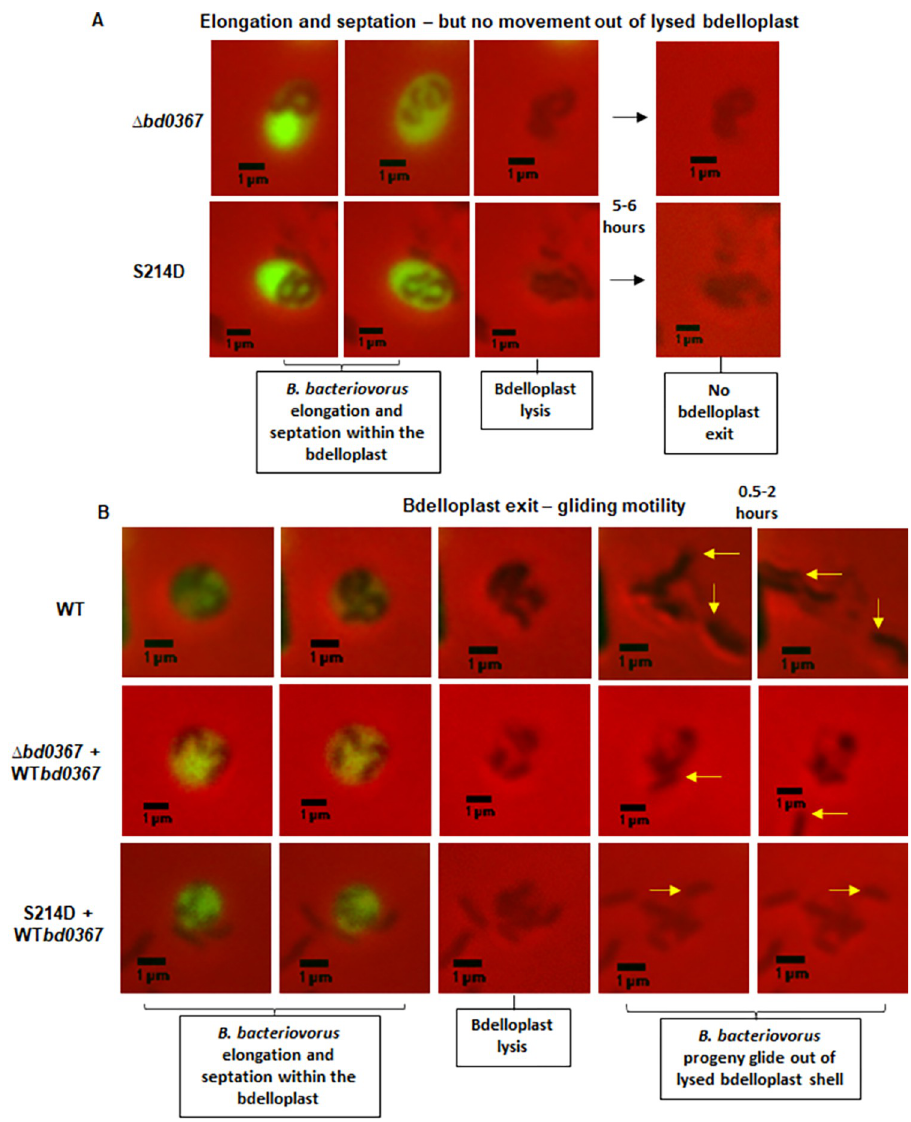
Fig 4. Testing the ability of B . bacteriovorus strains to exit from E . coli S17-1 prey on a hydrated 0.5% agarose pad. Stills from time-lapse microscopy are shown: A. The B . bacteriovorus bd0367 S214D site-directed mutant strain (S214D) invaded prey, predators elongated and septated, then bdelloplast lysis occurs, seen by rapid loss of prey fluorescence. However, no motile processive exit was observed and progeny remained in the prey remnant, as was also the case for the bd0367 deletion strain ( Δ bd0367 ). B. Replacing the mutant bd0367 genes with a wild-type copy gave strains of B . bacteriovorus which exited the bdelloplast by gliding motility as did the host-independent wild type strain HID13 (WT). The arrows highlight the new progeny B . bacteriovorus exiting the lysed bdelloplast. Scale bars are 1 μ m. Images are representative of three biological repeats.